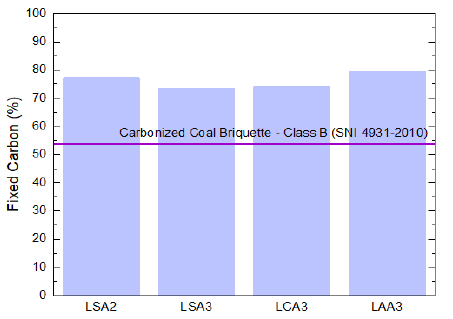
Figure 6. Fixed carbon of LS2, LS3, LAS3, and LAA3 samples compared to the carbonized coal briquette SNI 4931–2010.